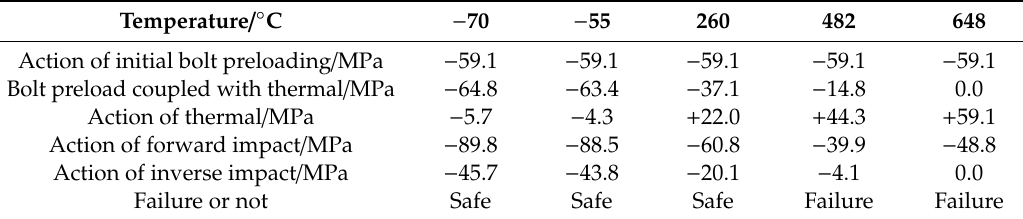
Figure 15. The relation of axial stress with respect to time with different temperatures Table 3. The responses of impact loads under different thermal conditions.